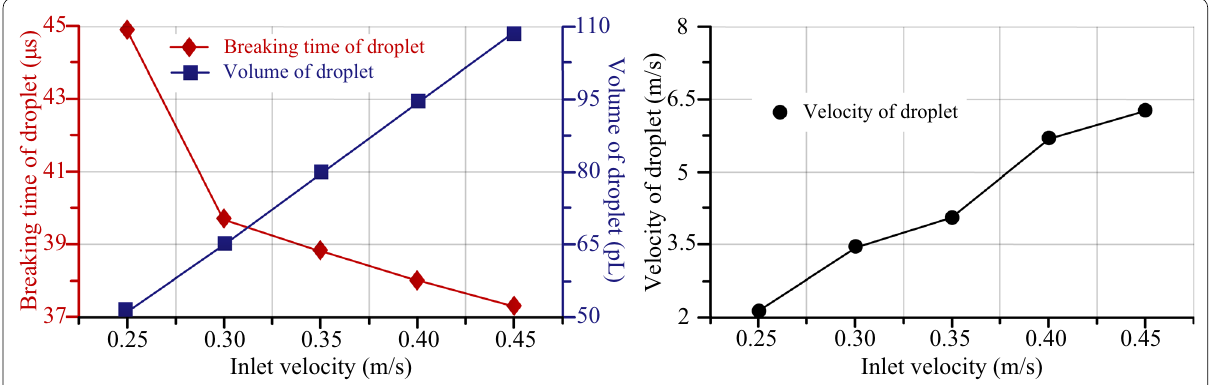
Figure 11 The relationship among breaking time of droplet, volume of droplet, velocity of droplet and inlet velocity